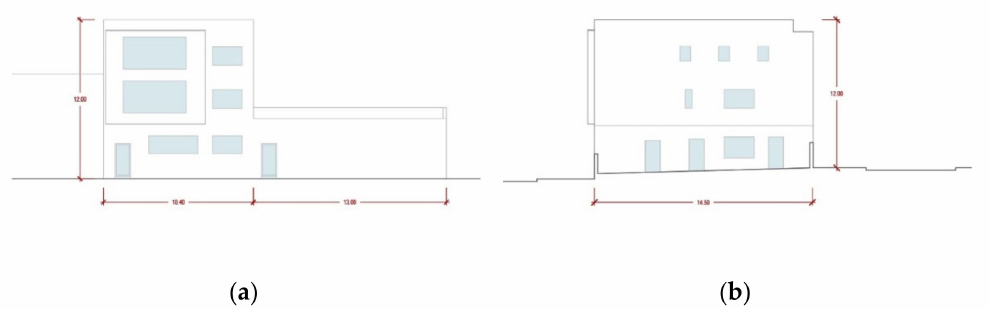
Figure 2. ( a ) Existing building: south-west elevation—current state; ( b ) existing building: south- east elevation.